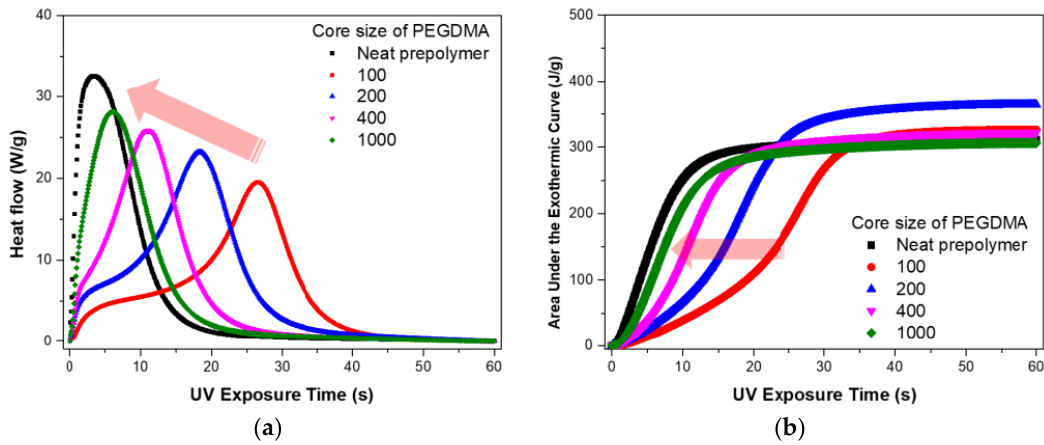
Figure 8. Reactivity for different PEGDMA sizes as determined using photo-DSC for a concentration of 10 phr: ( a ) peak heat flow; ( b ) total heat flow.